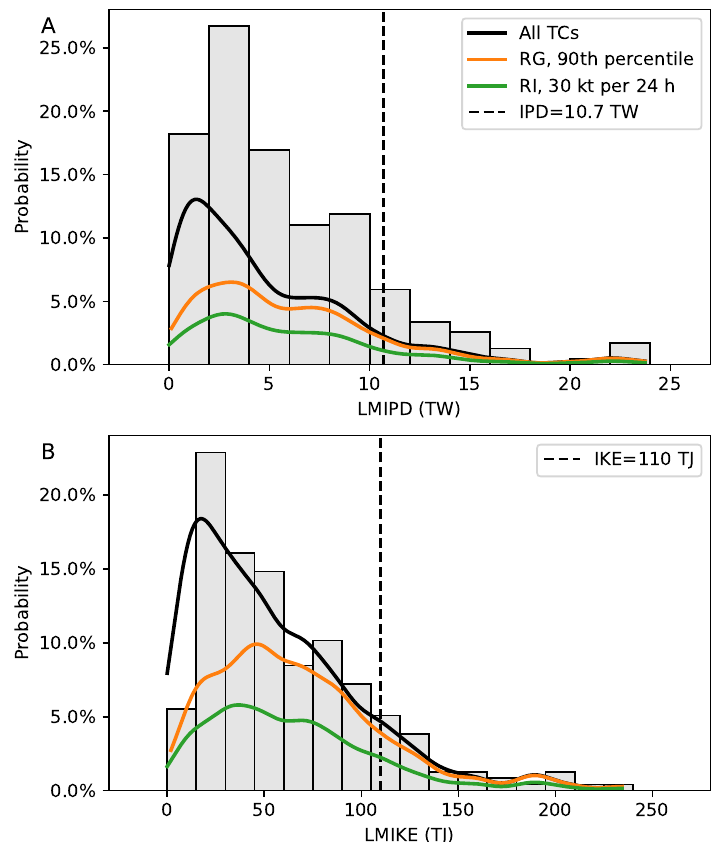
Figure 5. Probability distribution function (PDF) of the ( A ) lifetime maximum integrated power dissipation (LMIPD) and ( B ) lifetime maximum integrated kinetic energy (LMIKE) for the western north Pacific TCs. The original and smoothed distribution of all TCs are denoted by the grey histograms and black line, respectively. The PDFs for the TCs that undergo rapid growth, defined as the 90th percentile ( ≥ 84 km/24 h), and TCs undergoing RI ( ≥ 30 kt/24 h), are denoted by the orange and green lines, respectively. The PDFs are smoothed using kernel density estimation with a bandwidth of 0.2. IPD and IKE are computed using the revised Holland wind-profile model